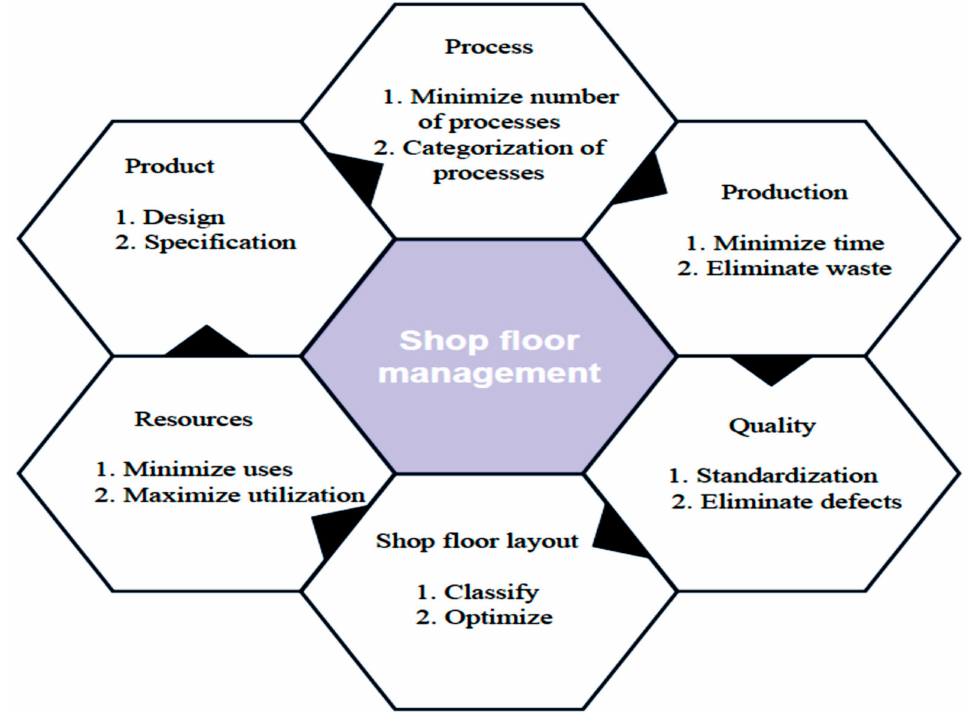
Figure 15. Production parameters for shop floor